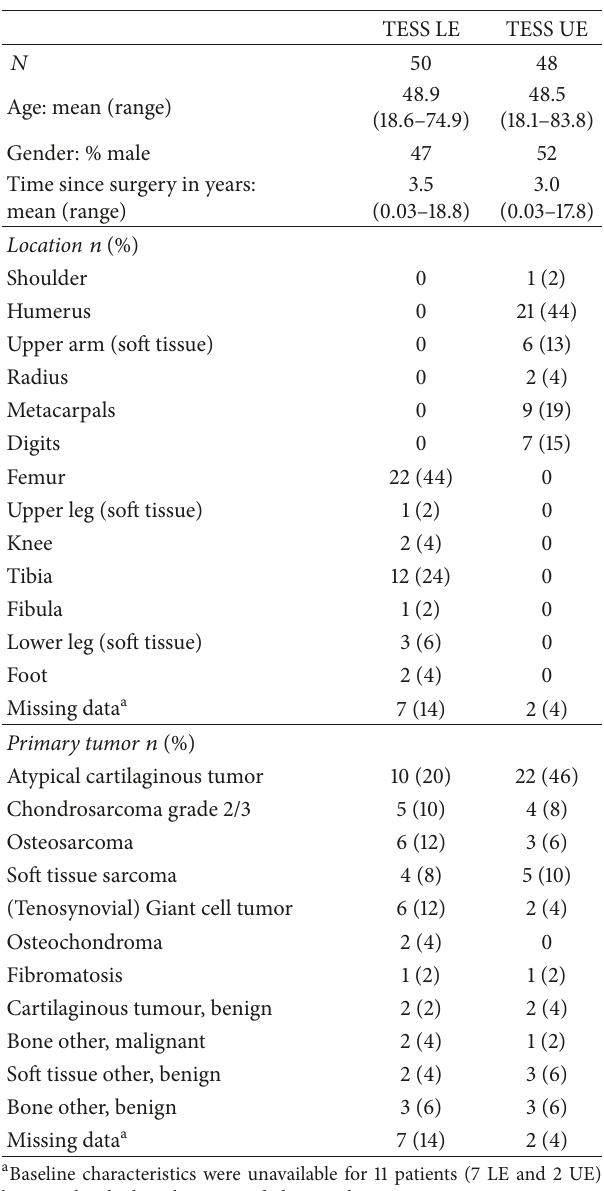
Table 1: Patient and tumor characteristics of patients with benign and malignant bone and soft tissue tumors who completed the TESS questionnaire.